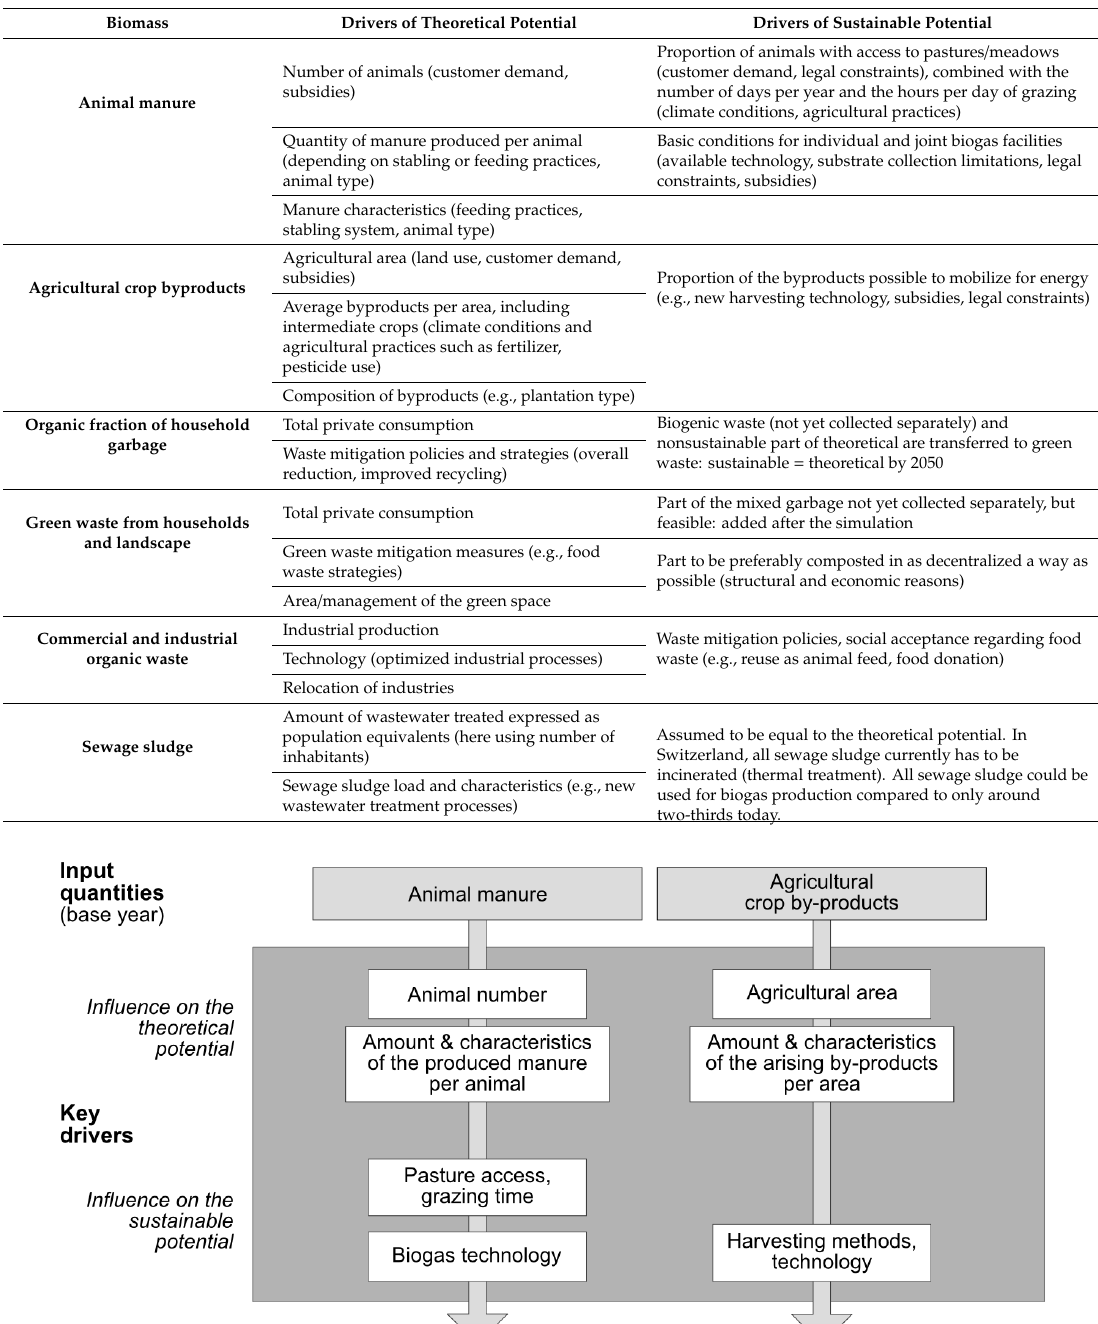
Table 1. Description of the selected drivers for all biomass types. Note that the drivers of the theoretical potential also apply to the sustainable potential.